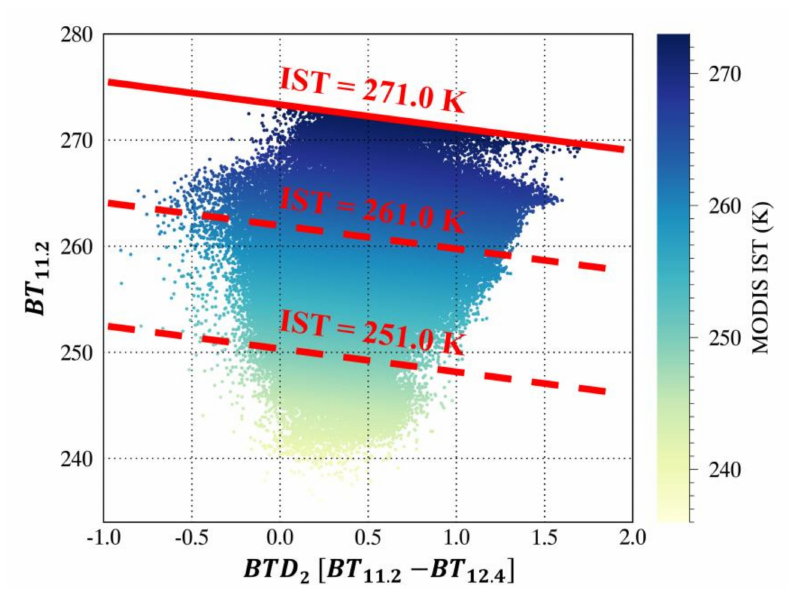
Figure 8. Distribution of relationship between BT 11.2 and BTD 2 [ = BT 11.2 – BT 12.4 ] using MODIS IST, Red line indicates that BT 11.2 and BTD 2 are linear in the 271.0 K environment where the sea water freezes. Red dotted line shows linear relationship. Dotted lines below indicate that BT 11.2 and BTD 2 are linear when IST = 261.0 K and IST = 251.0